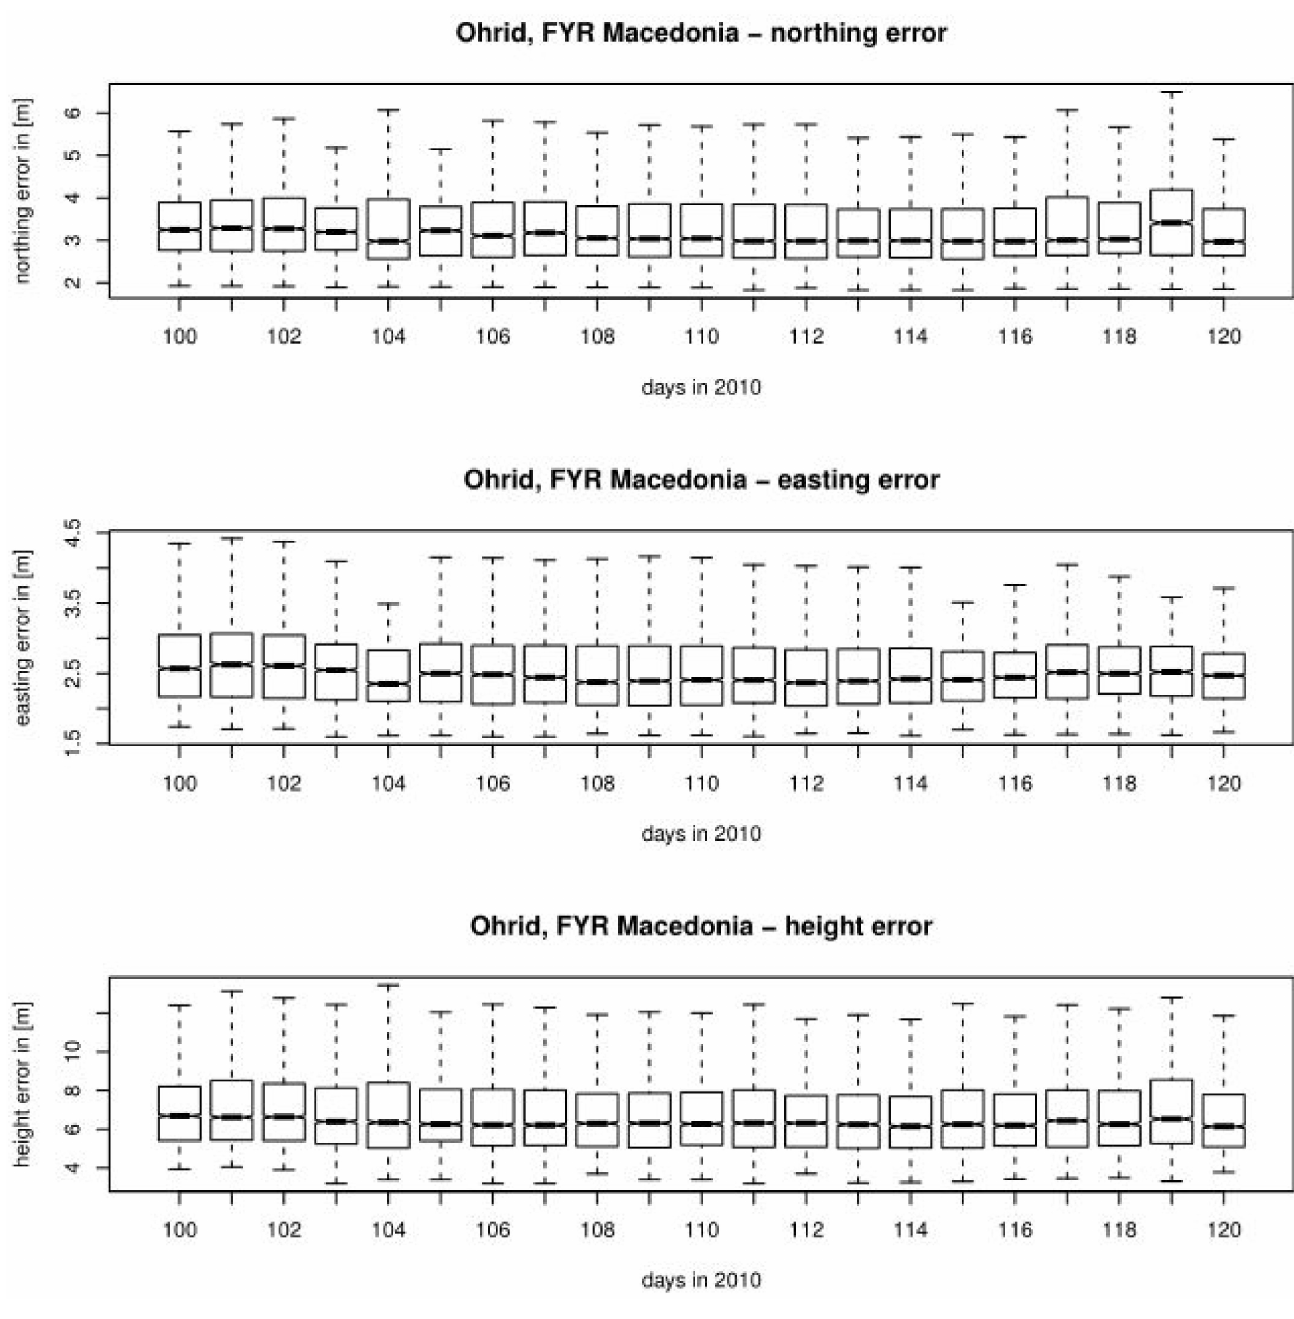
Figure 8. Box-and-whisker plot of GPS positioning errors as observed at Ohrid, Northern Macedonia reference station during days 100–120 in